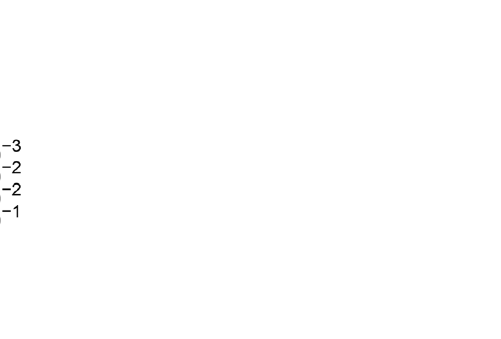
Figure 4. ( a ) Degree of match with the “g” pattern (blue) and “p” pattern (red). The initial conditions favor the “g” pattern, so the expected behavior is for the system to evolve towards a stable high degree of match, but the presence of frequency dispersion leads to a loss of stability, and eventually recognition of the “p” pattern occurs instead. Simulation used δ = 10 − 3 ( b ) Visualization of the same simulation. Second panel corresponds to the maximum of the blue curve in ( a ), last panel to the maximum of the red curve.